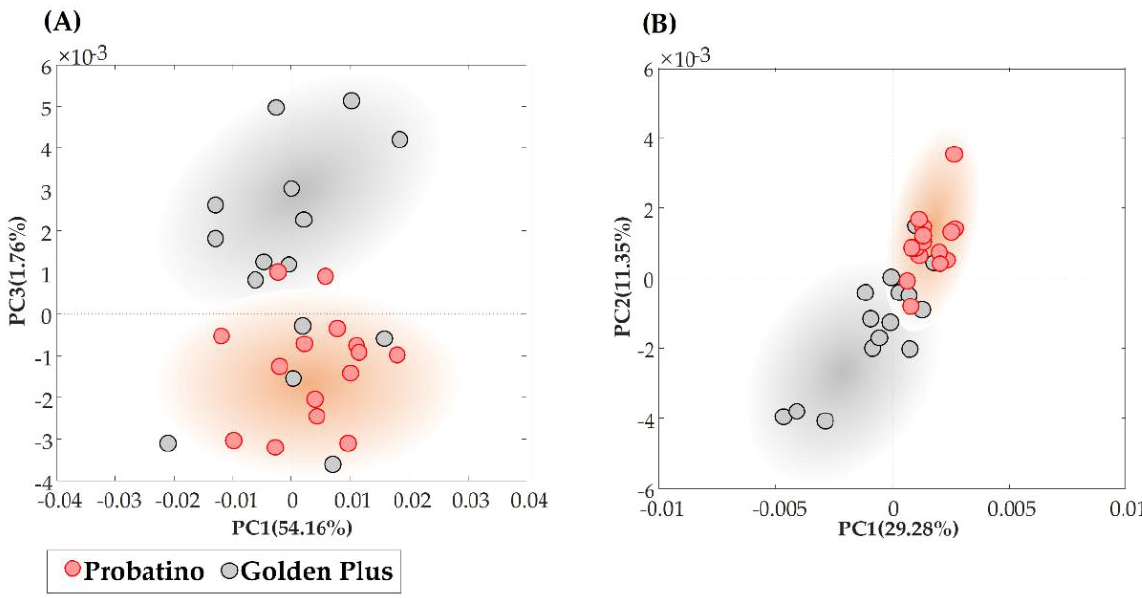
Figure 4. Interval Principal Component Analysis (iPCA) of the infrared spectra in the IR ( A )